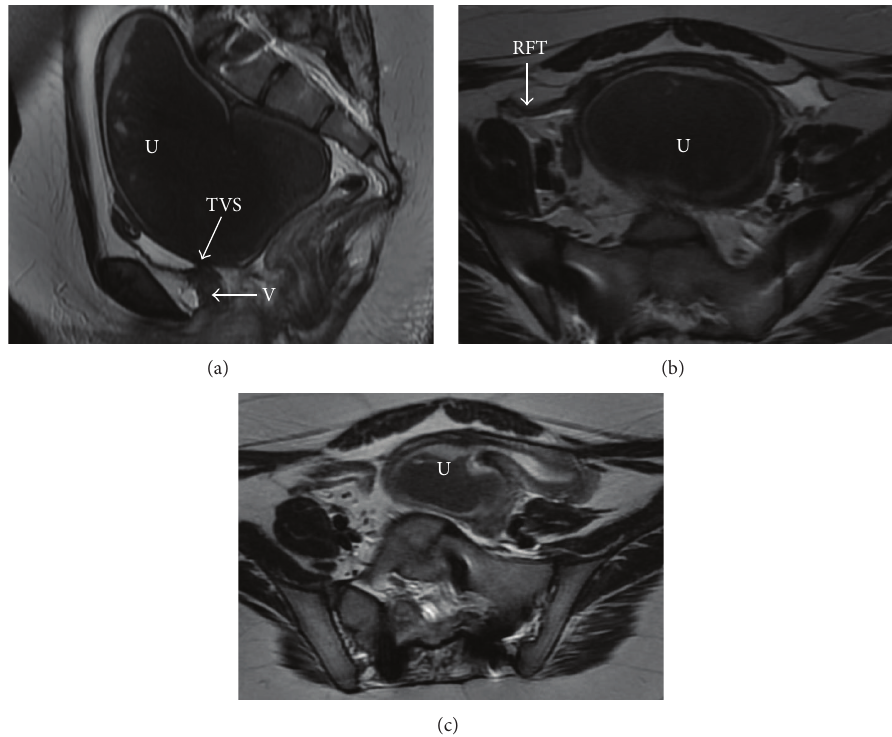
Figure 1: MRI of the pelvis, demonstrating site of transverse vaginal septum. (a) Sagittal T2 image, showing uterus distended with blood (U), the site of transverse vaginal septum (TVS), and narrowing at the level of vagina (V). (b) Axial T2 image, demonstrating distended uterus (U). (c) Axial T2 image, showing the distended left unicornuate uterus. U: uterus, TVS: transverse vaginal septum, V: vagina, and RFT: right fallopian